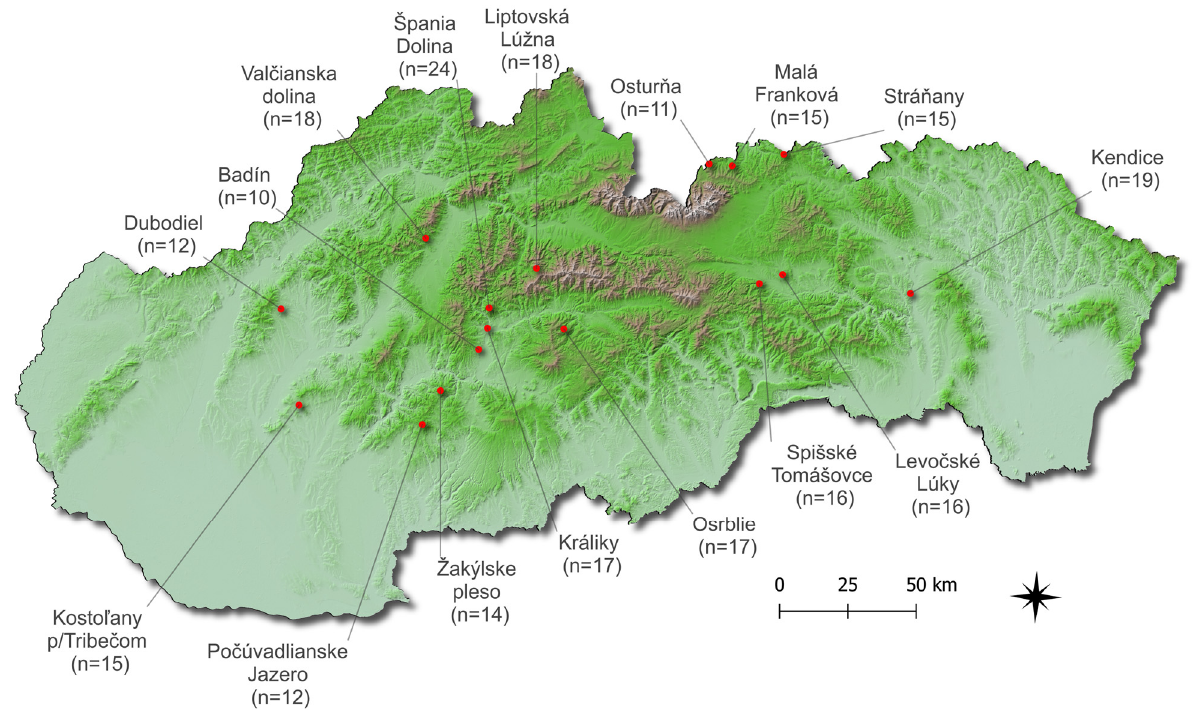
Figure 1. Mushroom and its underlying substrate sampling areas. Table 1. The number of collected samples of individual mushroom species in the sampling localities.